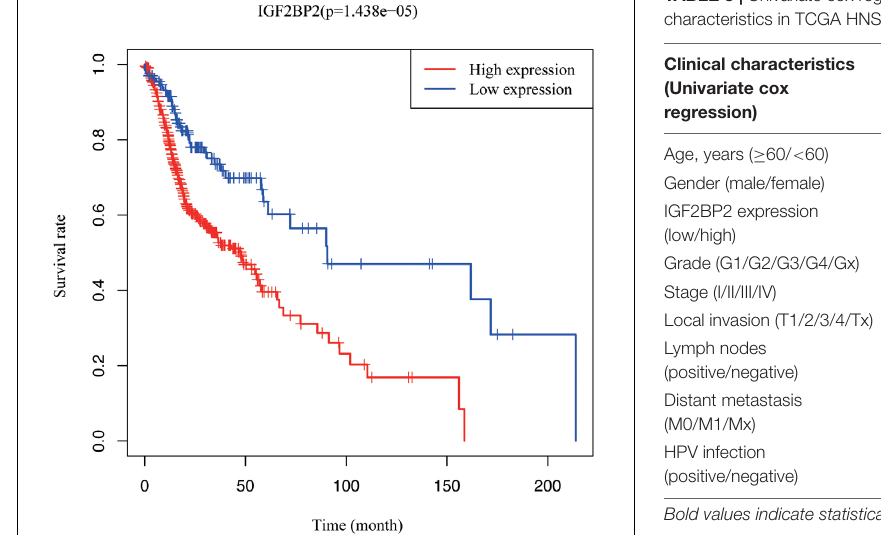
cancer pathways were significantly enriched in the group with high expression levels of IGF2BP2 .